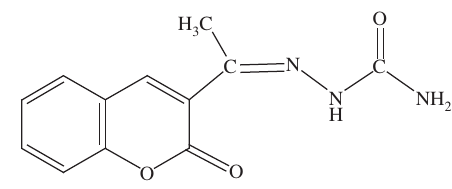
Figure 1 Structural formula of 3-acetylcoumarin semicarbazone.